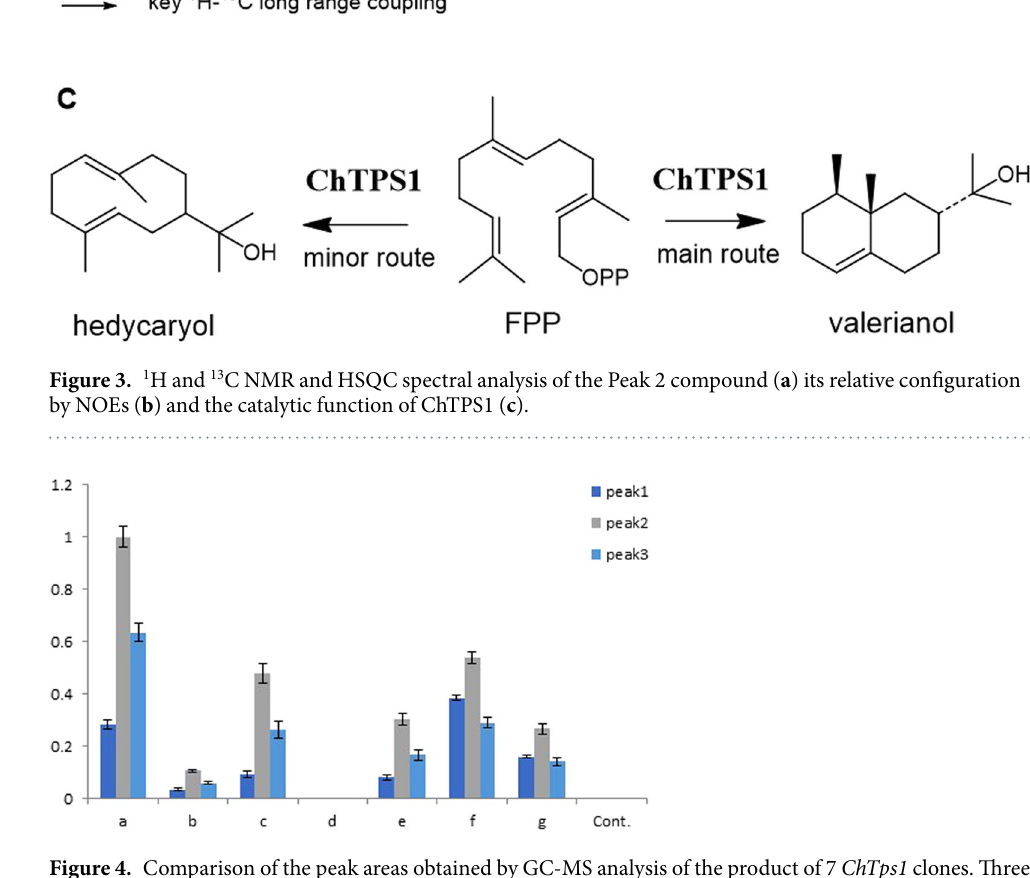
Figure 4. Comparison of the peak areas obtained by GC-MS analysis of the product of 7 ChTps1 clones. Three peak areas, shown in Fig. 2a (Peaks 1–3), of total ion chromatogram were obtained by GC-MS analysis of the ChTPS1 product. These peak areas of 7 ChTps1 clones ( a – g , shown in Table 1) individually were compared. Relative abundance of each peak was depicted when the Peak 2 area of ChTps1a clone was set to 1. Bars represent means ± standard deviation of three replicates. Cont. stands for empty vector